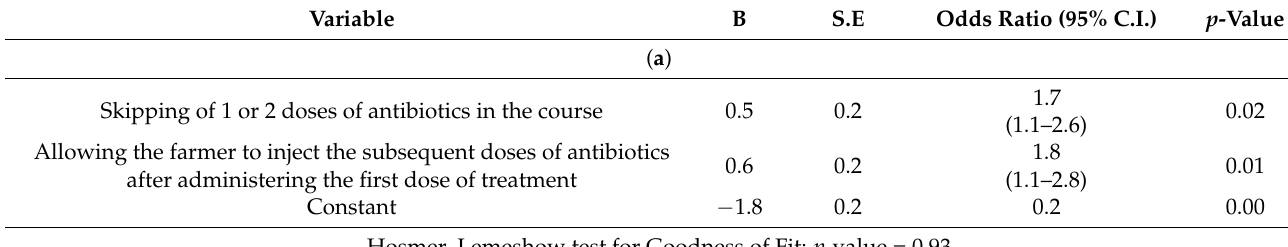
Table 5. Multivariable logistic regression analysis: ( a ) Veterinarians; ( b ) Farmers.